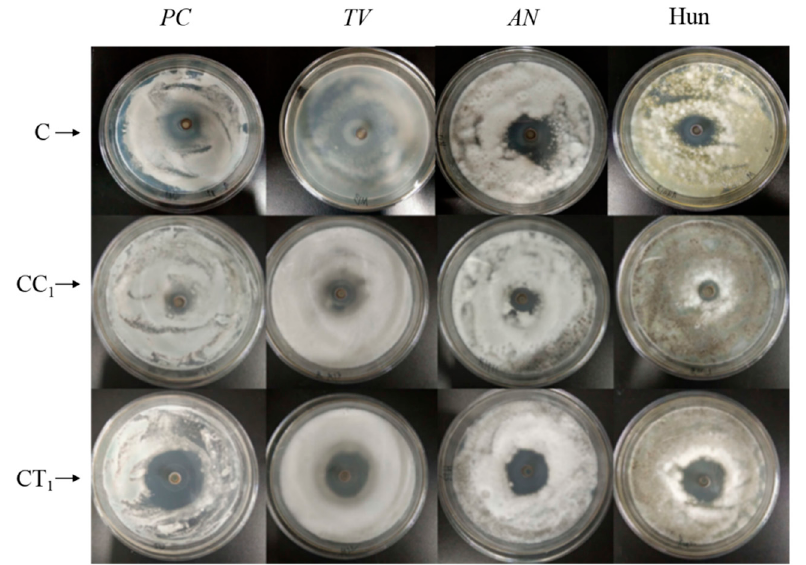
Figure 3. Inhibitory effect of citral and citral compound solutions against bamboo molds (C, citral solution; CC 1 , a compound formulated with citral and cinnamaldehyde; CT 1 , a compound formulated with citral and thymol).